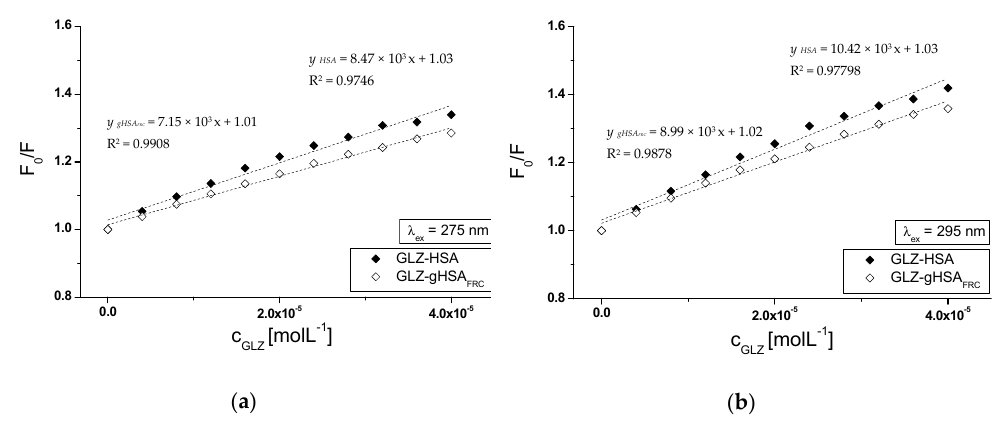
Figure 7. The Stern-Volmer curves for GLZ-HSA and GLZ-gHSA FRC . ( a ) λ ex = 275 nm and ( b ) λ ex = 295 nm; the error bars are smaller than the symbols. Table 2. Stern-Volmer constants K SV (mol − 1 · L) and biomolecular quenching rate constants k